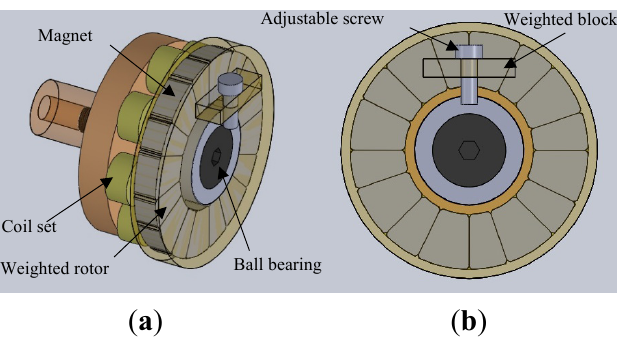
Figure 2. Schematic diagram of WREH. ( a ) 3D schematic view of the WREH for TPMS. ( b ) Weighted rotor composed of magnets, a weighted block, and an adjustable